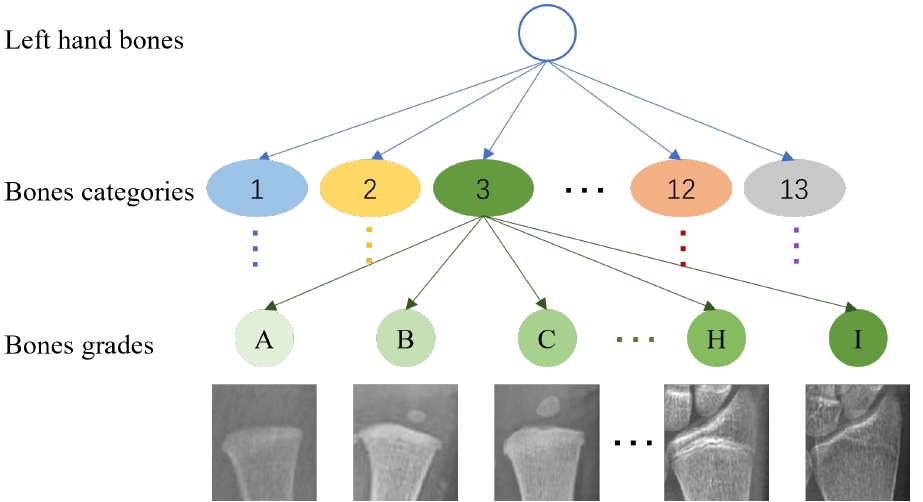
Figure 3. The tree structure of bone categories and grades. The thirteen colors, such as blue, yellow, green, orange, and gray, correspond to the thirteen categories, respectively (ulna, radius, the 1st proximal and distal phalanges, the 3rd proximal, middle, and distal phalanges, the 5th proximal, middle, and distal phalanges, and the 1st, 3rd, and 5th metacarpals). Different shades of each color represent different grades (A, B, C, D, E, F, G, H, I (ulna does not have an I-th grade)).